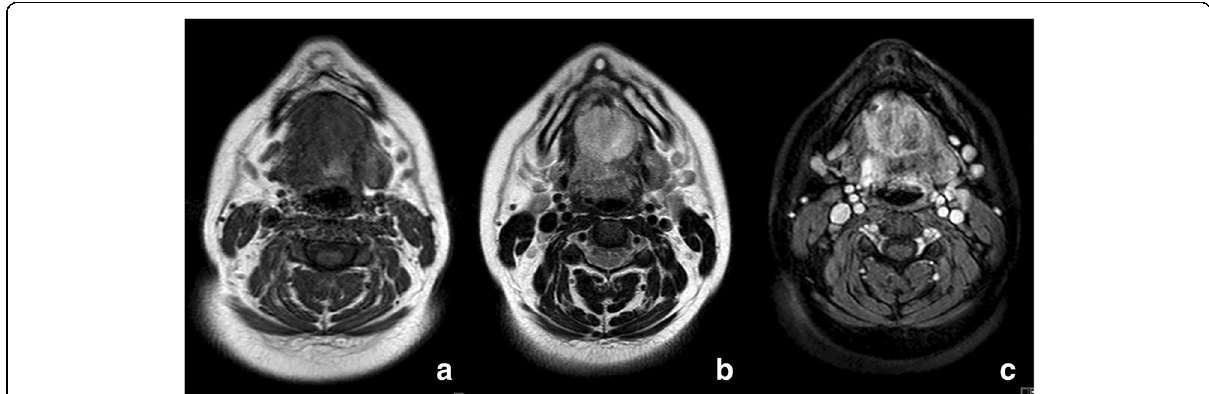
Fig. 10 SFT arising from the floor of the mouth. Axial T1-weighted ( a ), T2-weighted ( b ), and gadolinium-enhanced T1- weighted ( c ) MR images showing a large, well-defined mass. The mass has intermediate intensity signal on the T2-weighted image, isointense to muscle on the T1- weighted image showing moderate heterogeneous enhancement on the gadolinium-enhanced